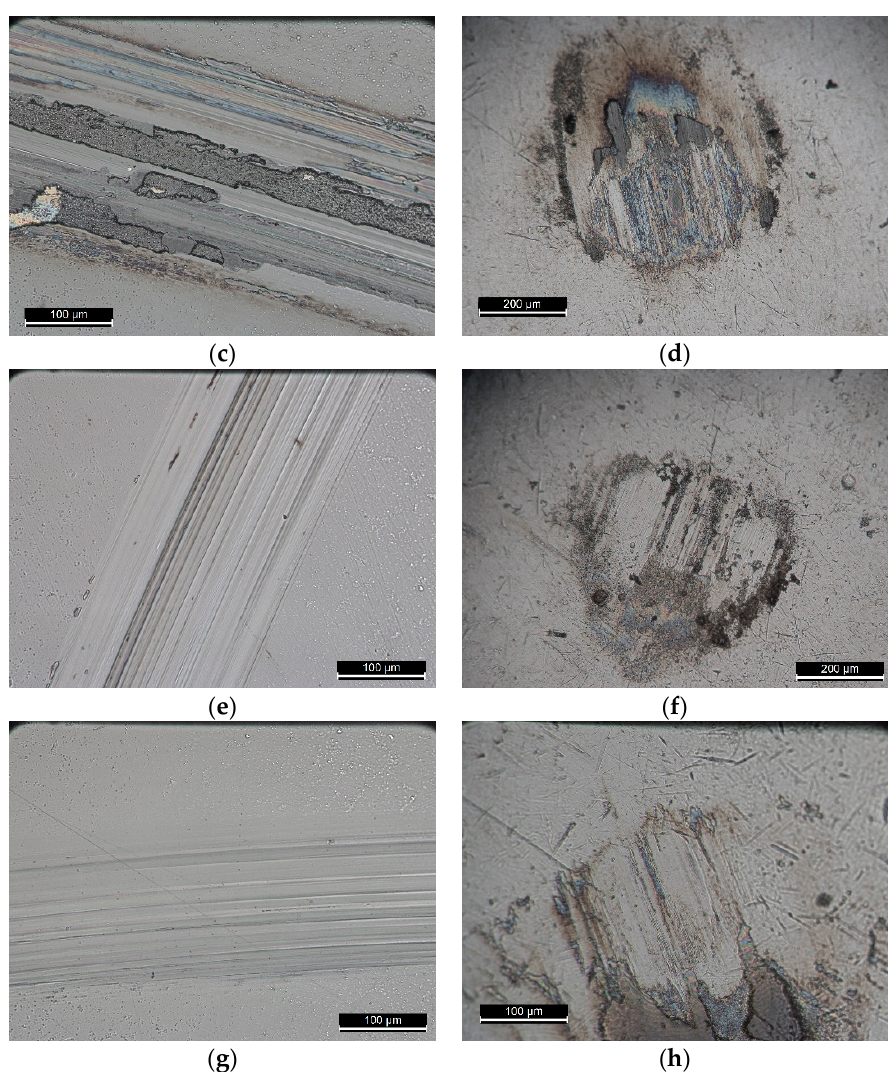
Figure 11. Optical micrographs of the wear tracks on the disk and the wear scars on counterbodies: ( a ) D1-450 disk; ( b ) D1-450 ball; ( c ) D2-17 disk; ( d ) D2-17 ball; ( e ) D3-17-disk; ( f ) D3-17-ball; ( g ) D4-38 disk; ( h ) D4-38 ball.